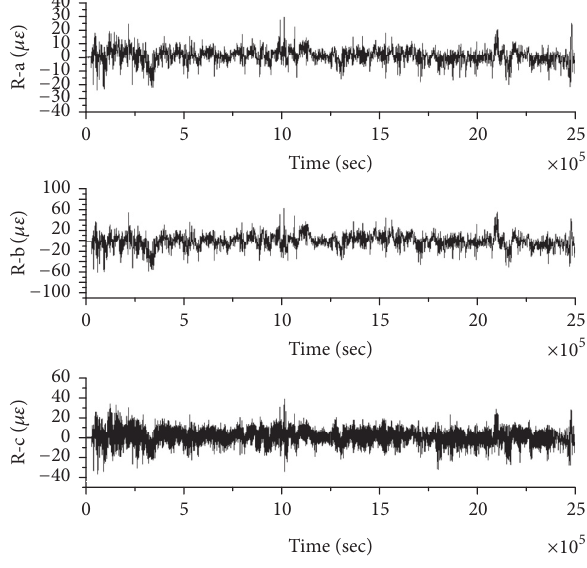
Figure 12: Strain occurring in track test (Point